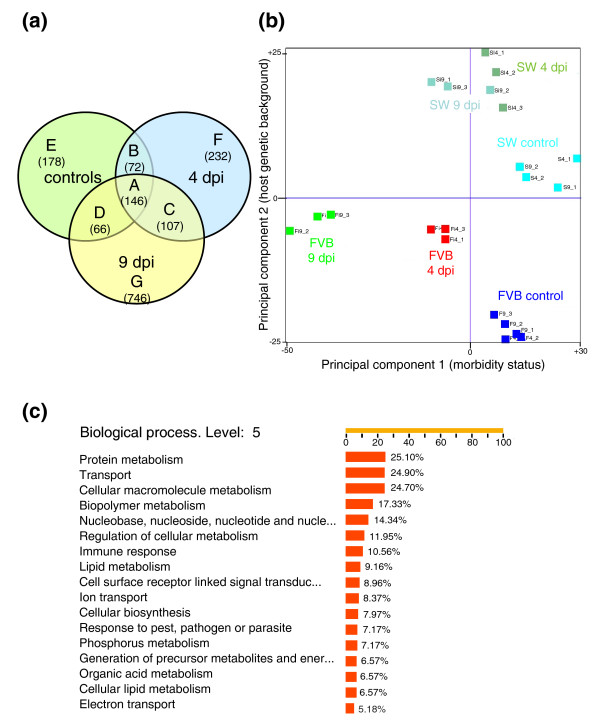
Genes contributing to host susceptibility. (a) Comparative analysis of gene expression profiles of SW versus FVB genes prior to infection or at 4 and 9 dpi is shown as a Venn diagram. Overall, 1,547 genes were differentially expressed between the lines of mice (Additional data file 5) and divided into 7 distinct subsets. Group A represents genes that were differentially expressed between the mouse lines at all time points. Groups B, C, and D represent genes that were differentially expressed at two conditions/time points. Groups E, F, and G represent genes unique to uninfected status, 4 dpi and 9 dpi, respectively. Each subset represents the comparison of resistant outbred SW mice to susceptible inbred FVB mice at the indicated time point. Numbers in parentheses represent the number of differentially expressed probe sets in each group. Significantly enriched GO clusters (p < 0.05 by hypergeometric test) for each group and for all sets of genes with host effect are given in Additional data file 20. (b) PCA distinguished SW from FVB mice in PC2. PC1 established negative correlation of infected and uninoculated FVB mice, but did not discriminate SW mice by infection status. Thus, PC1 represents morbidity associated with infection. (c) The prevalence of genes within GO categories was assessed by FatiGO analysis. Only categories containing more than 5% of genes are shown. Genes from transport processes were overrepresented.